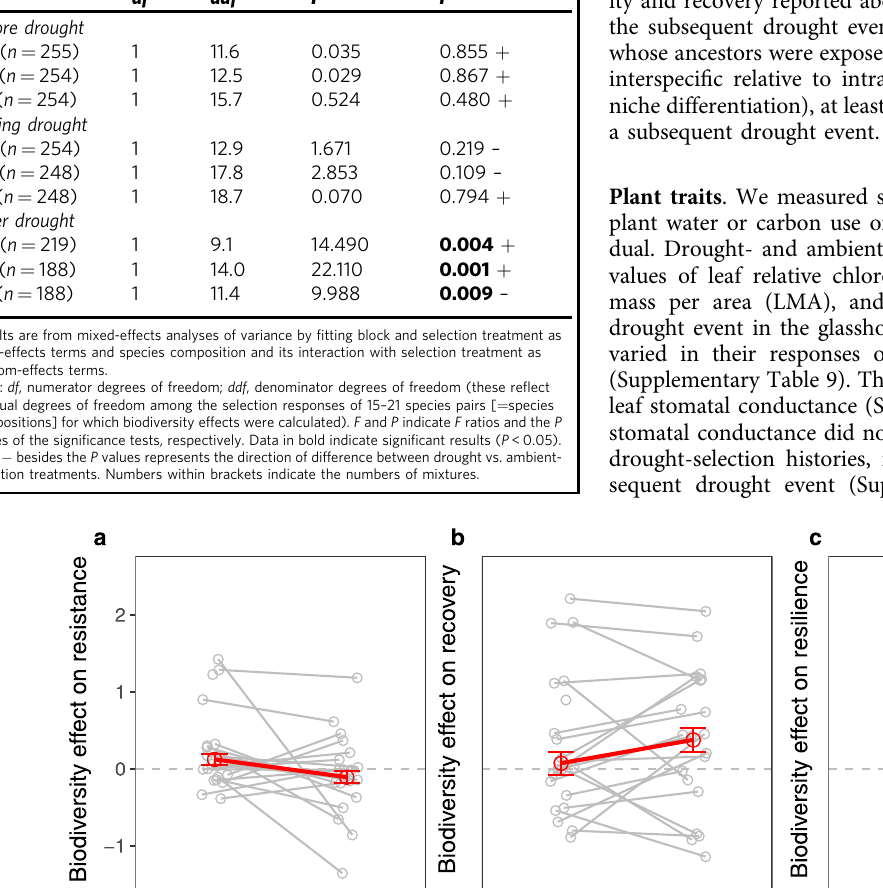
Table 1 Signi fi cance tests for the effects of selection treatment on net biodiversity effect (NE), complementarity effect (CE), and sampling effect (SE) on productivity before, during, and after the drought event in the glasshouse. df